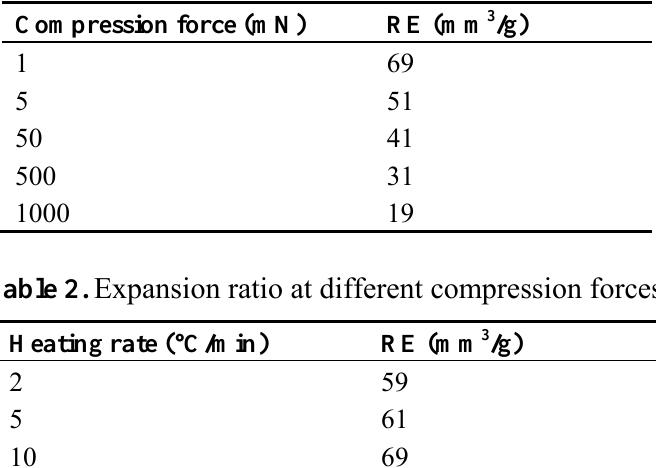
Table 1. Expansion ratio at different compression forces.